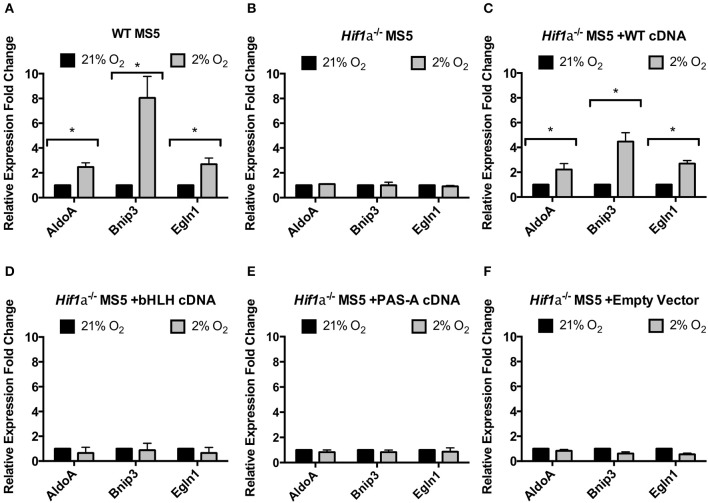
Functional properties of Hif1a cDNA mutants. Relative levels of Hif-1α target genes mRNA expression in (A) WT MS5 cell line, (B)
Hif1a−/− MS5 Clone 41 cell line, (C)
Hif1a−/− MS5 Clone 41 cell line transduced with a WT Hif-1a cDNA lentiviral construct, (D)
Hif1a−/− MS5 Clone 41 cell line transduced with a bHLH-mutated Hif1a cDNA lentiviral construct, and (E)
Hif1a−/− MS5 Clone 41 cell line transduced with a PAS-A-mutated Hif1a cDNA lentiviral construct, and (F)
Hif1a−/− MS5 Clone 41 cell line transduced with an empty lentiviral construct, cultured in 21 or 2% O2. Expression levels were calculated according to the ΔΔCt method normalizing against β-Actin (housekeeping gene) and considering 21% O2 as the reference condition for the calculations. *p < 0.05 paired t-tests, n = 3.